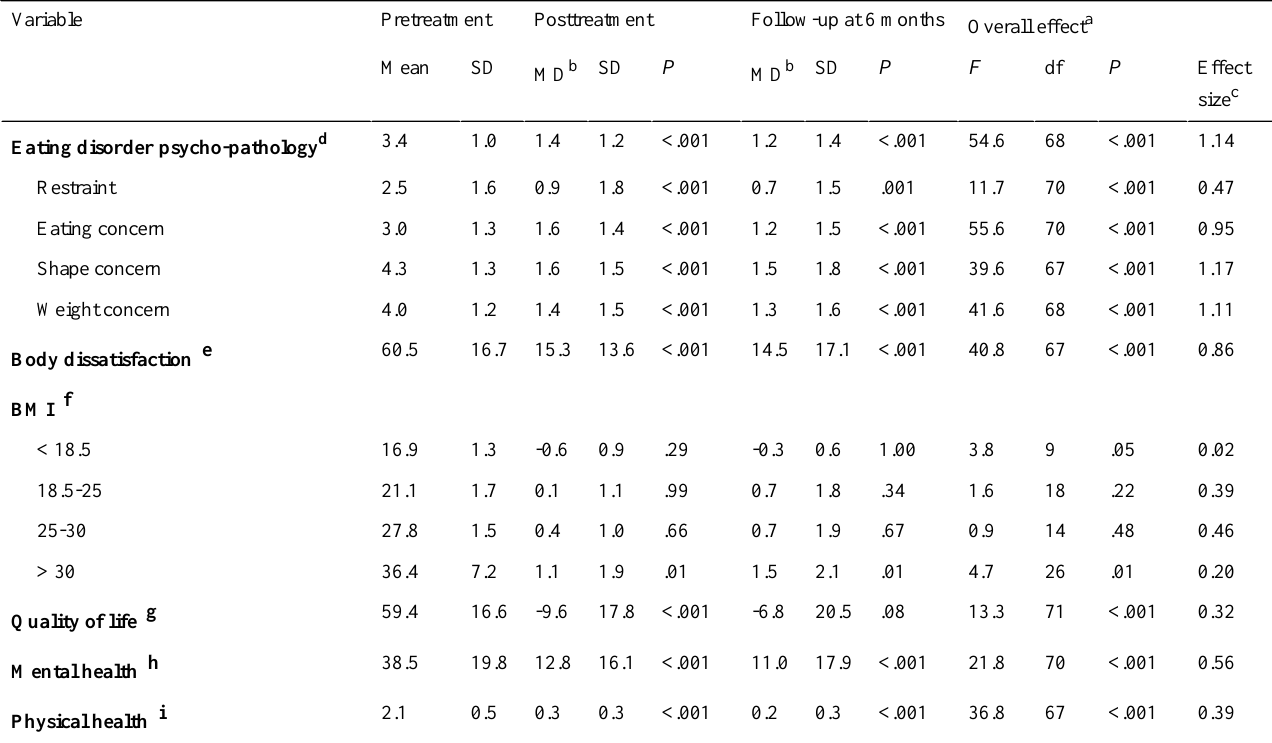
Table 3. Treatment outcomes for all participants.